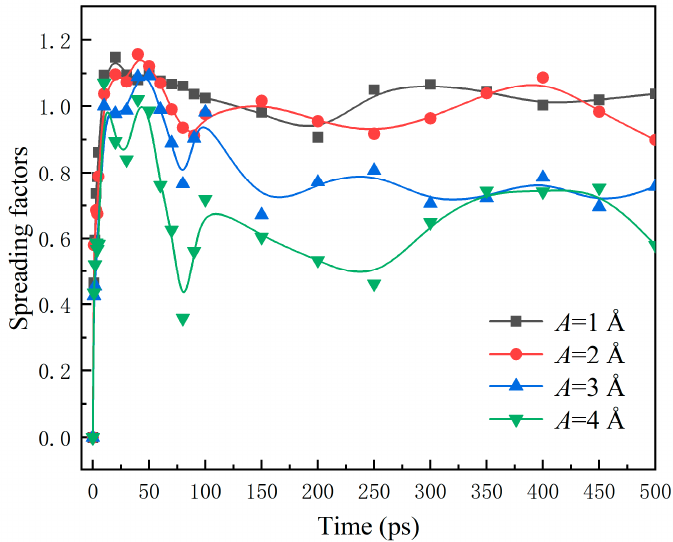
Figure 14. Time evolution of spreading factors of droplets impinging on surfaces with different vi- bration amplitudes.